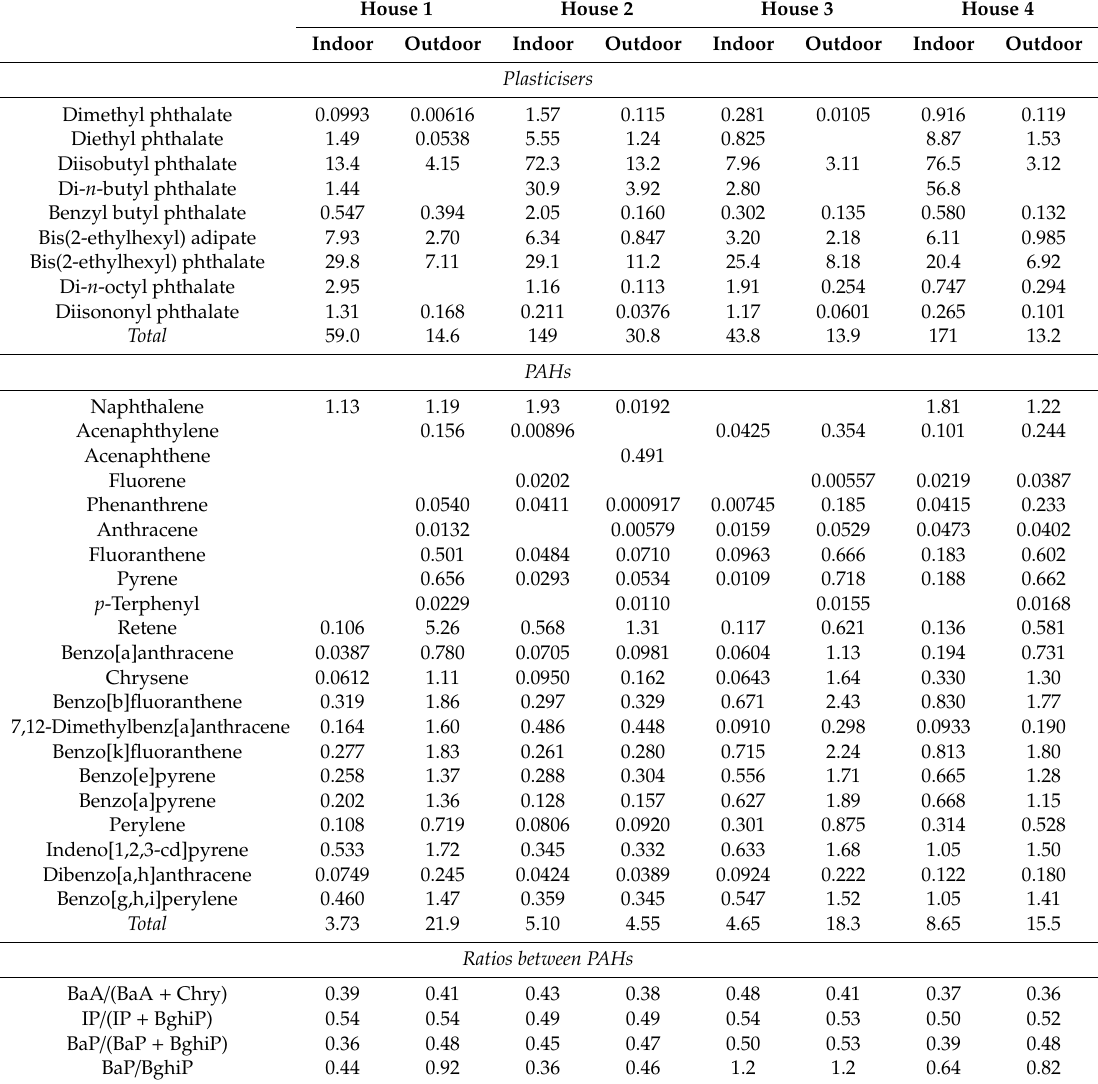
Table 6. Indoor and outdoor concentrations (ng m − 3 ) of plasticisers and polyaromatic compounds and diagnostic